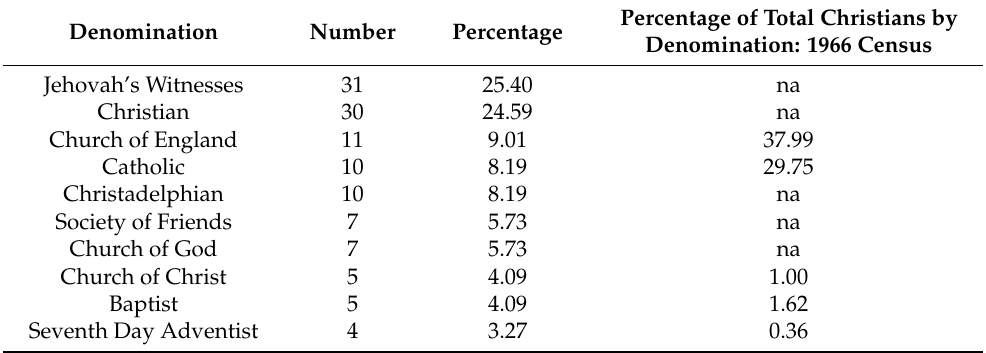
Table 2. Known Australian Christian Conscientious Objectors by-Decision-of-a-Court 1965–72. By